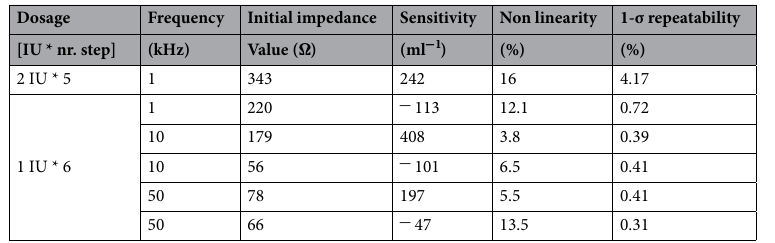
Table 3. In vivo experimental